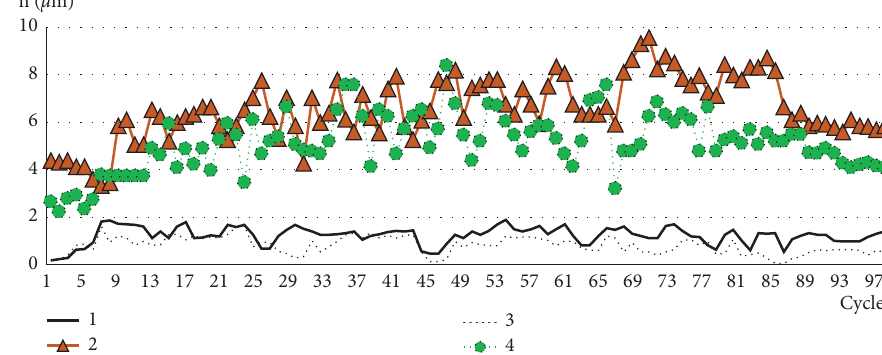
Figure 5: Formation of boundary adsorption layers (1 and 3) and the total thickness of the lubricating layer (2 and 4) in friction contact during operation: 1 and 2: sample 1; 3 and 4: sample